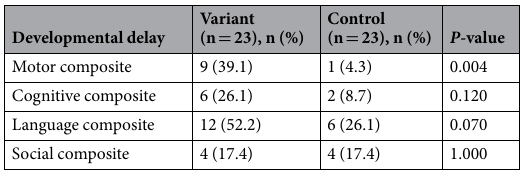
Table 5. The proportion of developmental delay in preterm infants according to the g.-273G > A variation at 18–22 months of corrected